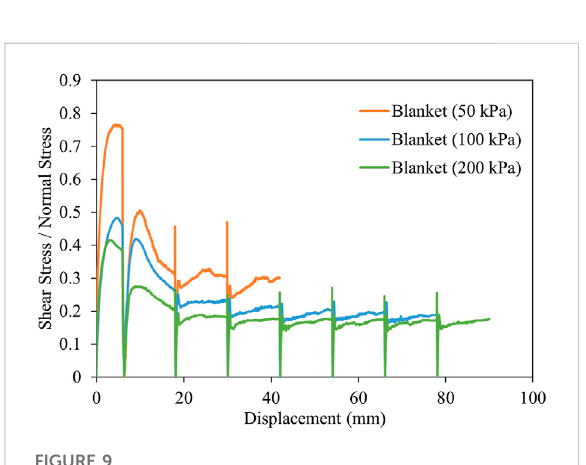
FIGURE 9 Normalized stress-displacement behavior of CB clay blanket samples from direct shear tests.